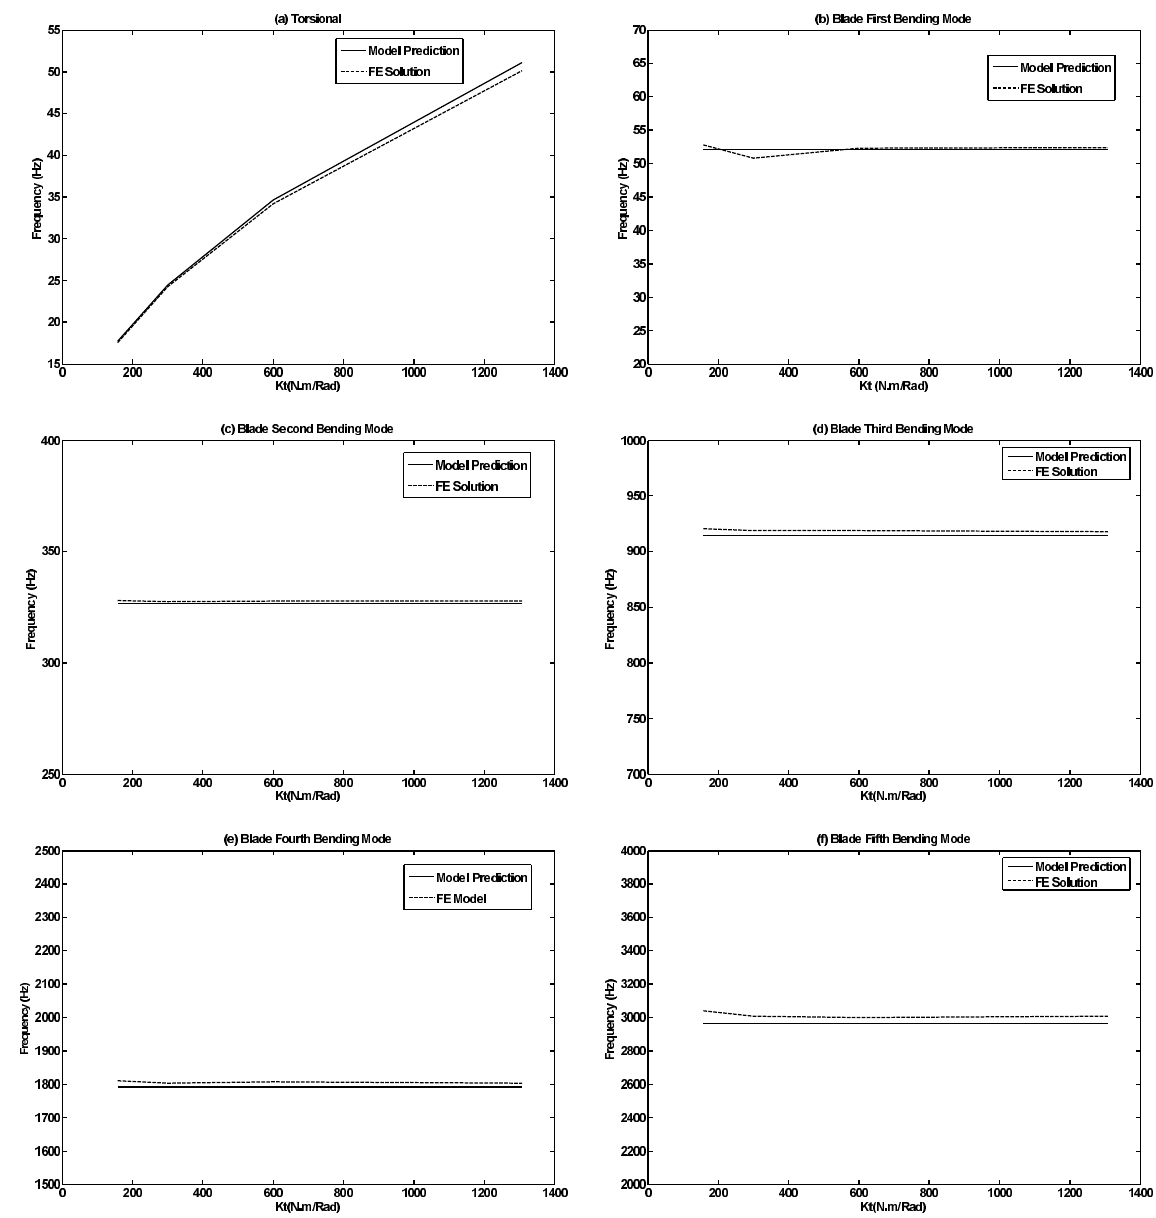
Fig. 11. Natural frequencies as function of k T Comparison for both Predicted Model and FE Solution at β = 90 ◦ . minimum value for the torsional stiffness k T below which the system torsional degree of freedom goes unstable due to system rotation softening effect. The variation in blade bending natural frequencies with k T becomes very minor as the rotating speed increases for higher modes. The effect of disk radius R d on the system natural frequencies for different values of setting angle β is investigated and the results are given in Fig. 4. As shown the effect of increasing R d is reducing the system natural frequencies for all values of setting angles for the non-rotating system effect of disk radius for the rotating system shown in Fig. 5 is increasing the natural frequencies of the blade bending modes and decreasing the torsional natural frequency. This behavior can be easily referred to the stiffening effect in the blade bending modes and the softening effect in the shaft torsional mode as R d